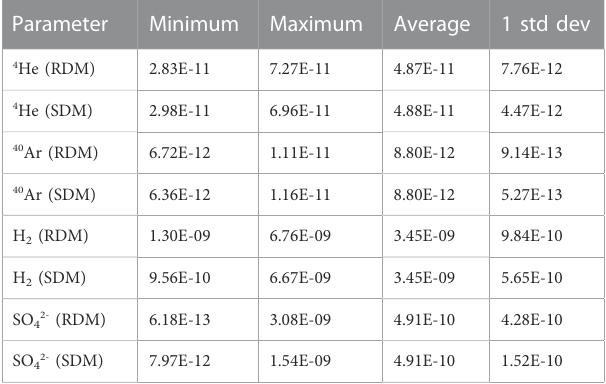
TABLE 2 Production rates for 4 He, 40 Ar, H 2 , and SO 4 2- per bulk m 3 of rock per year determined using Eqs 1 – 9, coupled with the two Monte Carlo modelling approaches incorporating the input parameters provided in Table 1 and described in full in the main text. Each value represents the result of one million generated values via the two Monte Carlo models RDM and SDM. All production rates are in moles per bulk m 3 per